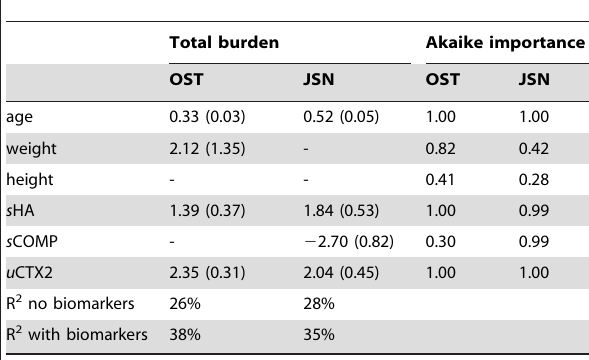
Table 2. Predictors and their coefficients comprising the minimum-AIC models for percentage of maximum osteoarthritis